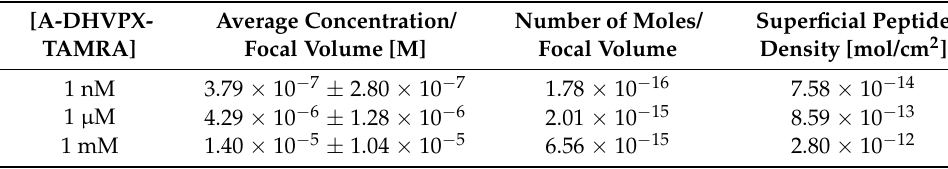
Table 2. Evaluation of differently functionalized samples at TPM.